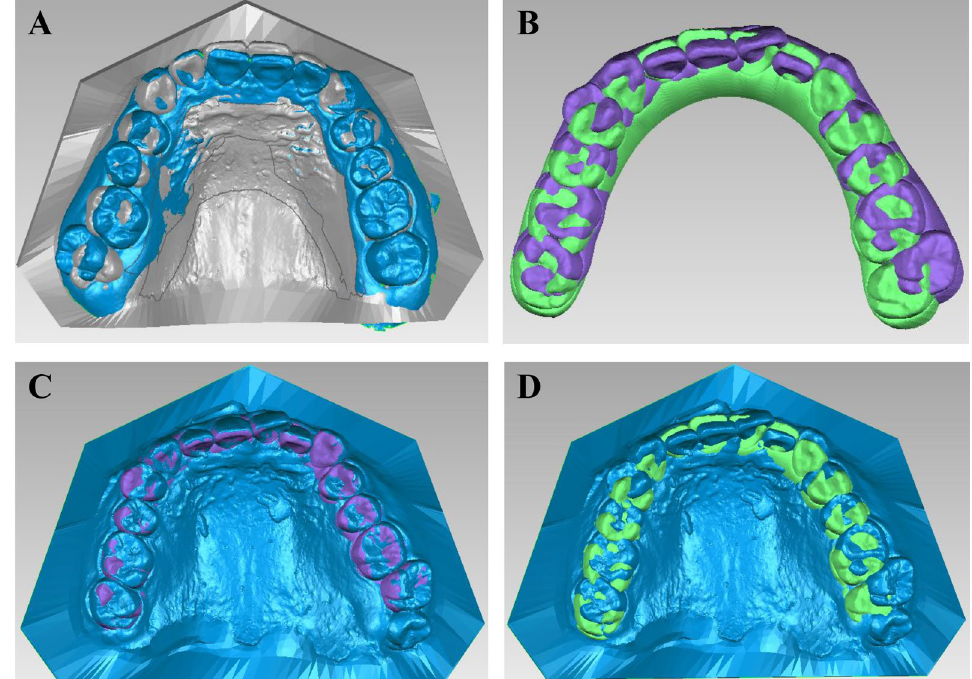
Fig. 2 Superimposition of models. A Superimposition of T0 (blue) and T1 (gray) based on the palatal vault region. B Automatic registration of T0-CC (purple) and T1-CC (green) when exported from ClinCheck. C Superimposition of T0 (blue) and T0-CC (purple) by the same dental arches D Superimposition of T0 (blue) and T1-CC (green) mediated by